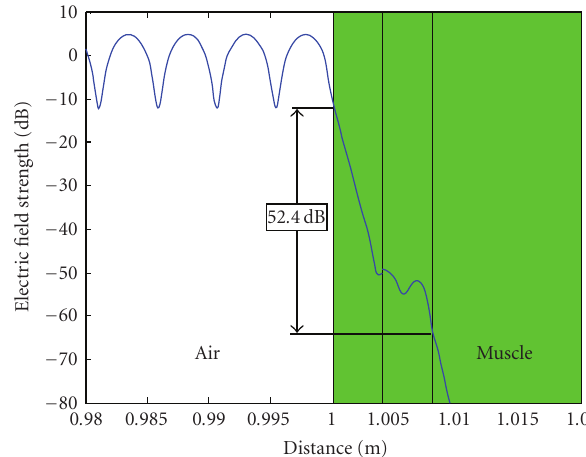
( | E t | / | E o | ). External 10